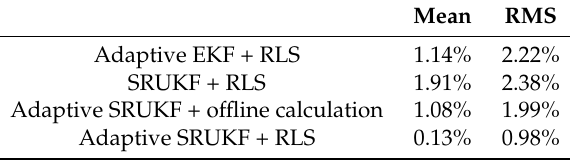
Table 2. Statistical results of the SOC estimation errors.